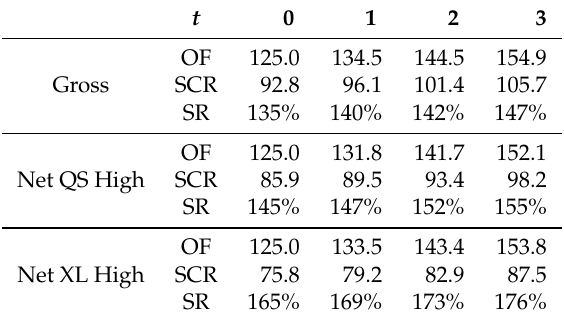
Table 10. Solvency Ratio (SR) for Tau during the following 3 years (amounts in mln of Euro) (Baseline Ptf—20%